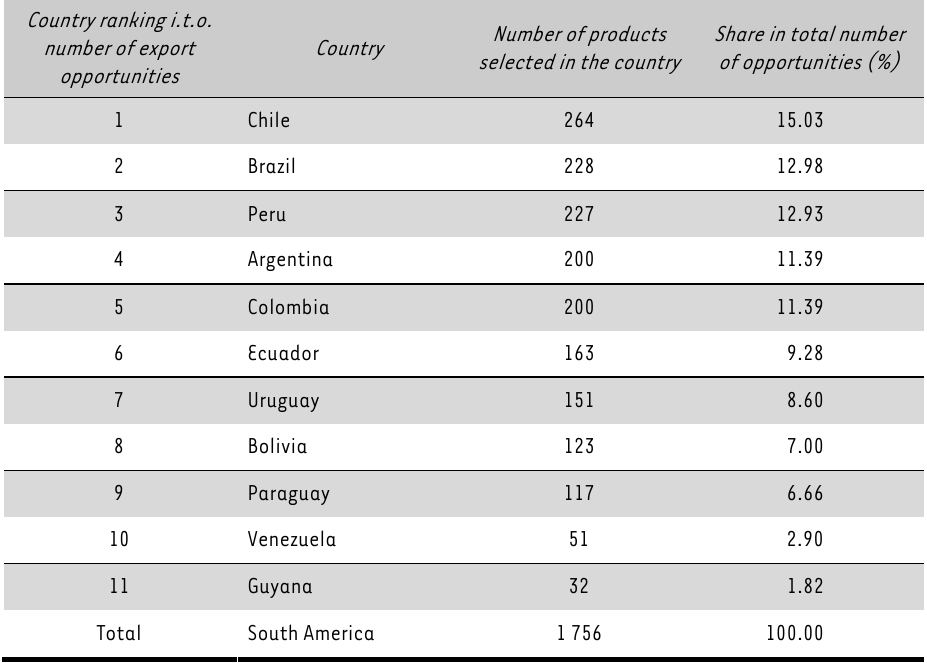
TABLE 8: South American countries ranked according to the number of export opportunities identified for South Africa Country ranking